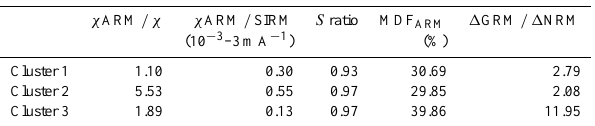
Table 2. Cluster center properties obtained from fuzzy c-means